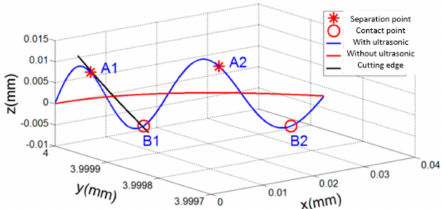
Figure 2. Cutting edge trajectories of longitudinal-torsion ultrasonic-assisted milling (LTUM) and traditional milling